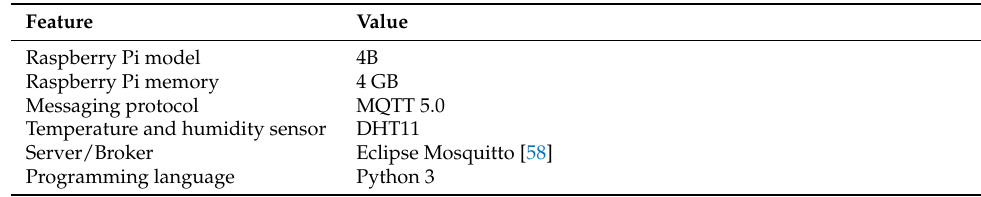
Table 3. Characteristics of the IoT